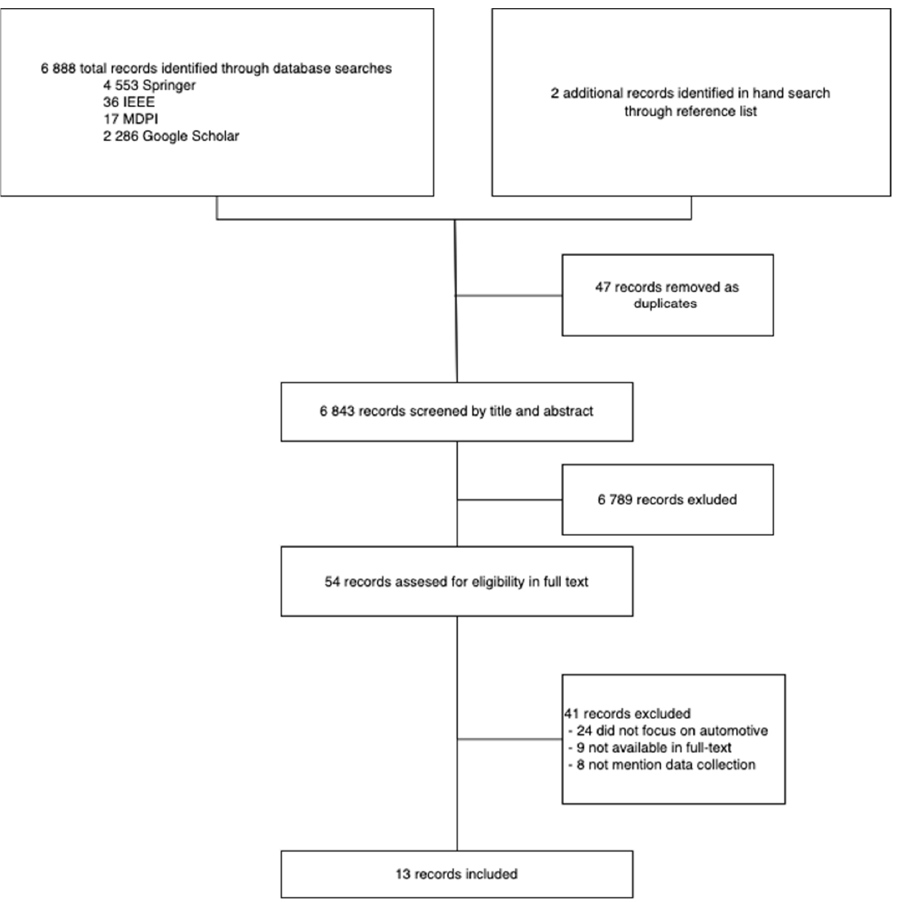
Figure 1. Diagram of the review process flow.